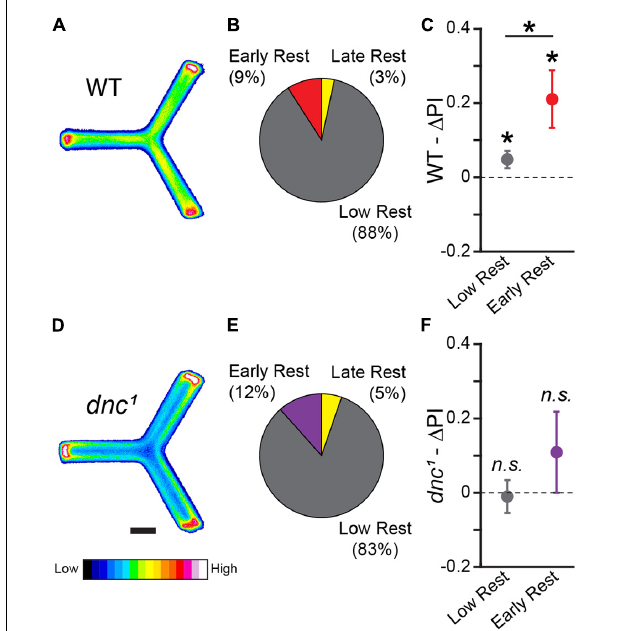
FIGURE 7 | Y-track operant learning is dependent on cAMP regulation. (A,D) Position heatmaps of trained WT (A) and dnc 1 (D) flies. Scale bar is 5 mm. Color shows relative occupancy of each pixel from low to high. (B,E) Fraction of WT (B) and dnc 1 (E) flies with each rest phenotype. (C,F) Mean (cid:49) PI of low rest (restless) and of early rest (drowsy) WT (C) and dnc 1 (F) flies. The mean (cid:49) PI of drowsy and restless WT files are both greater than zero (One-sample bootstrap test; p = 0.005 and p = 0.019, respectively). The mean (cid:49) PI of drowsy WT flies is greater than the mean (cid:49) PI of restless WT files (Two-sample bootstrap test; p = 0.035). Error bars are standard error of the mean, n.s. : groups are not significantly greater than zero, * groups are significantly greater than zero or different from one